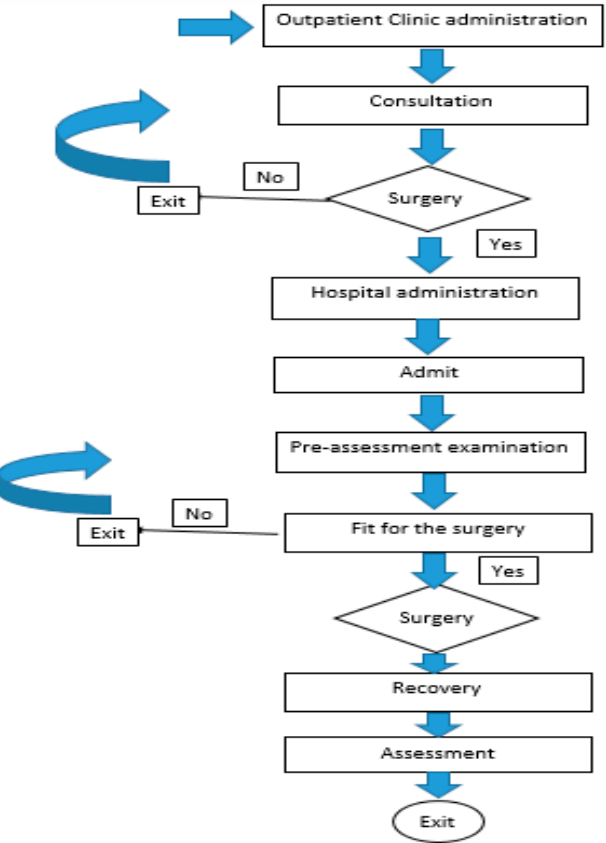
Figure 8. Algorithmic workflow for a smart contract with surgery patients.